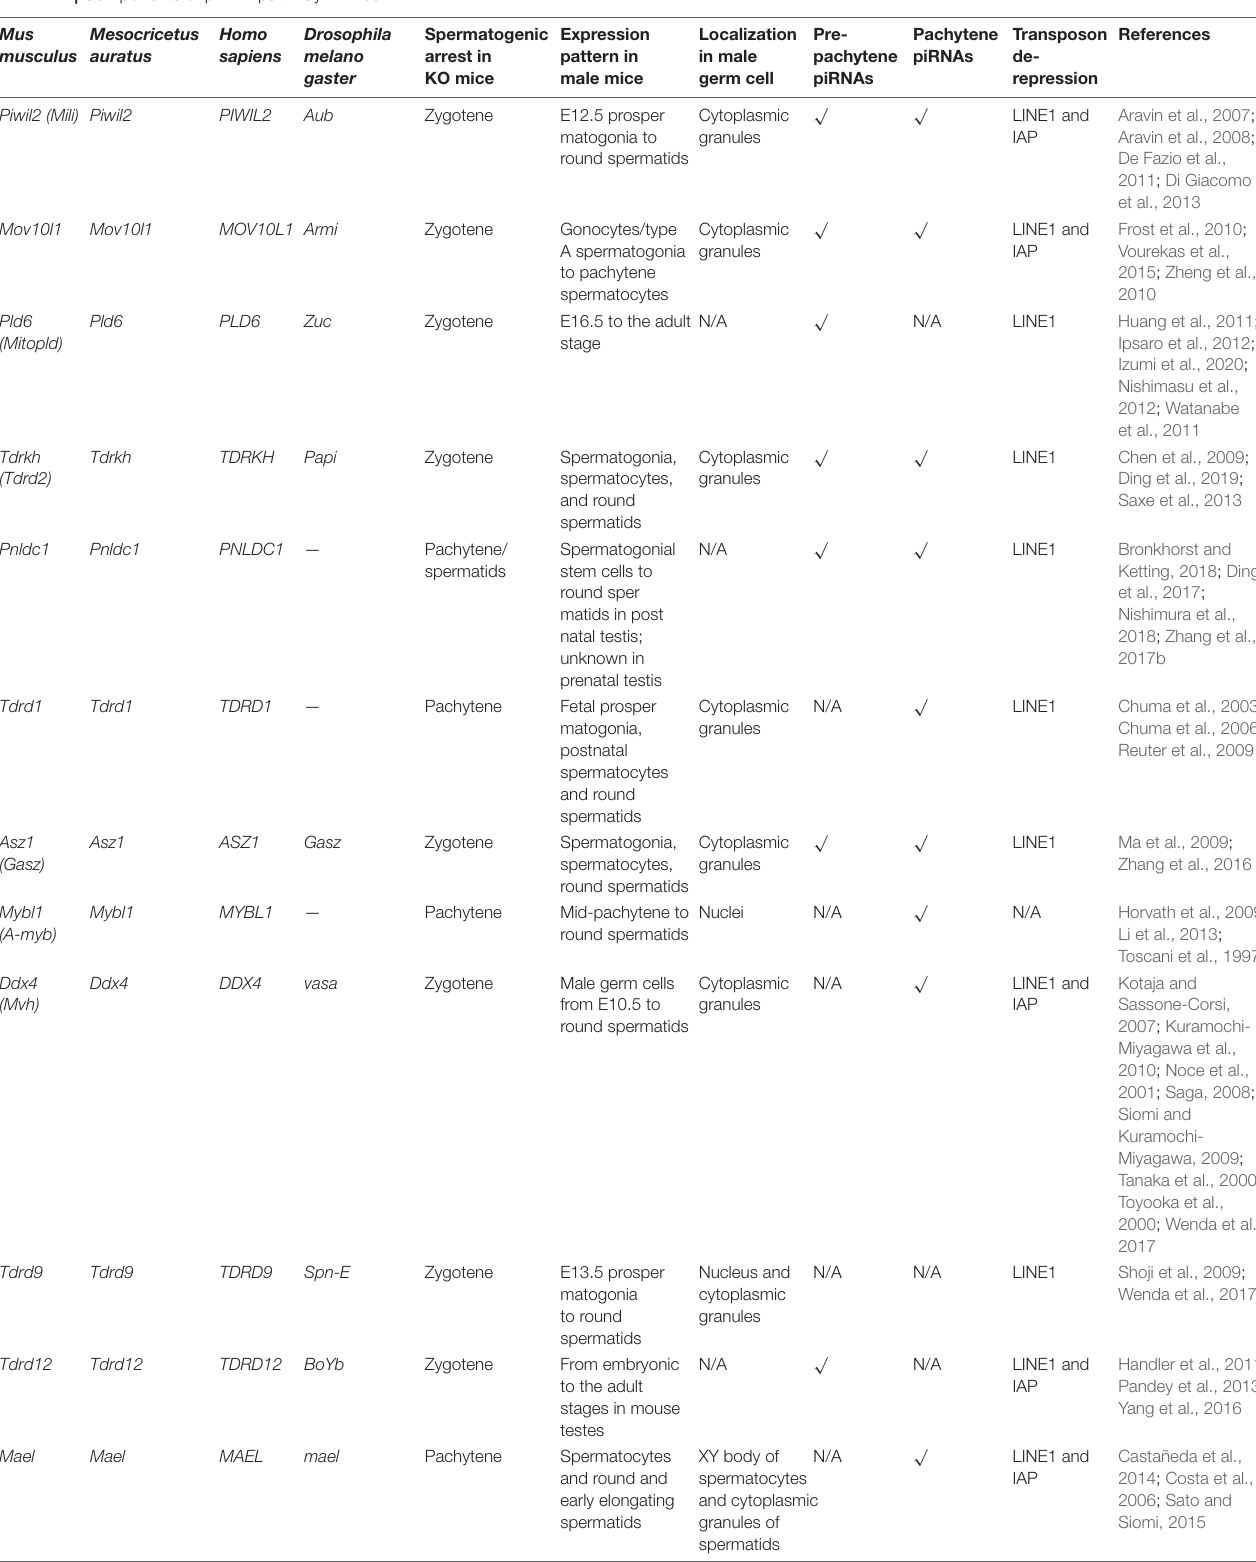
TABLE 1 | Components of piRNA pathway in